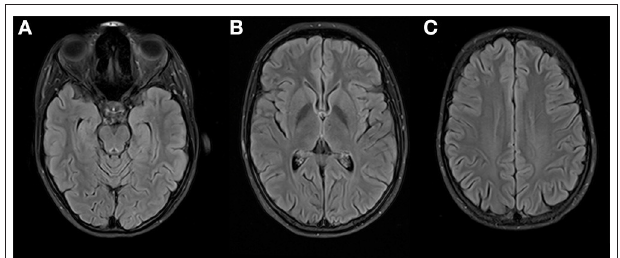
FIGURE 2 | Brain imaging at 3 Tesla MRI (T2 FLAIR weighted) on three different levels (A–C) shows no suspicious signal alterations, especially on both mesial temporal lobes (A) and insula (B)